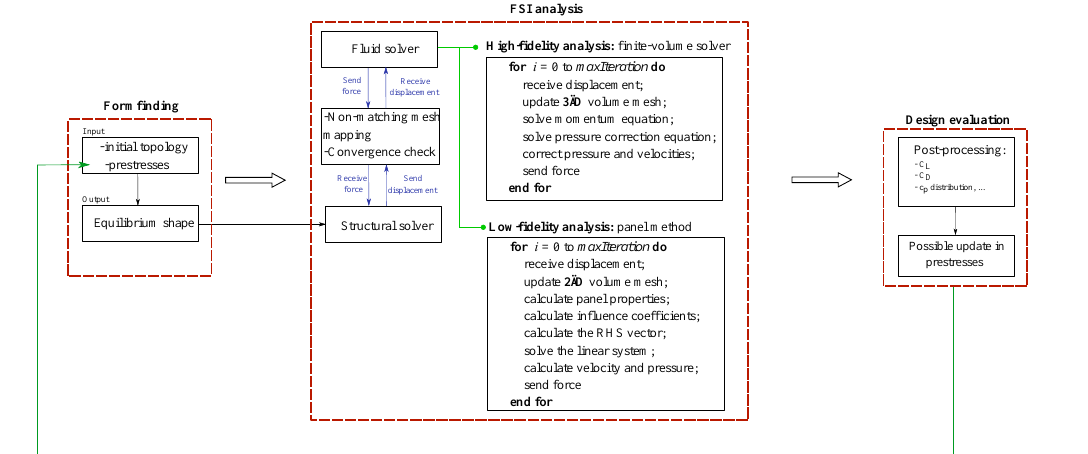
Figure 3. Schematic representation of the multi-fidelity analysis work